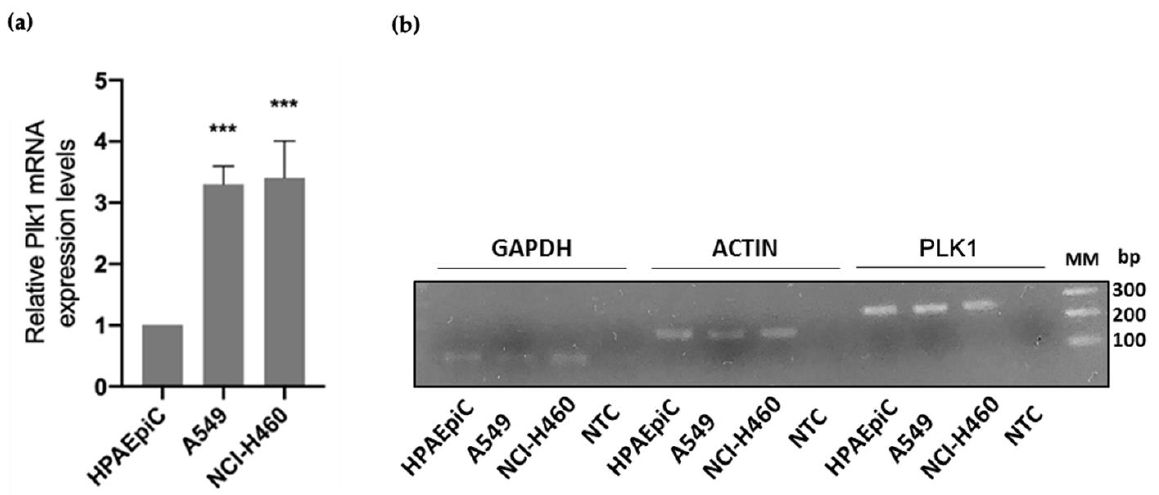
Figure 1. PLK1 is overexpressed in NSCLC cell lines. ( a ) Relative mRNA expression of PLK1 was determined by qRT-PCR in NCI-H460 and A549 cancer cell lines, and compared to non-tumor HPAEpiC cell line, showing PLK1 overexpression in tumor cell lines with statistical relevance of *** p < 0.001 by unpaired t -test from three independent experiments. ( b ) Representative 1% agarose gel image of PCR products is shown. MM-molecular marker; bp-base pair; NTC-Non-Template Con- trol.